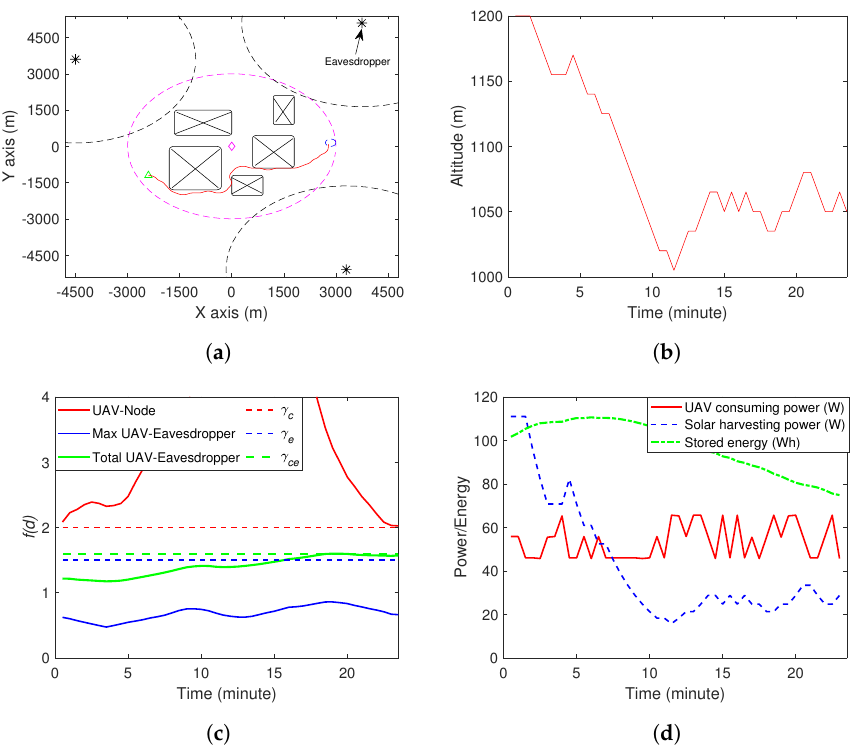
Figure 2. Simulation results in Environment 2 by the proposed method. ( a ) The UAV movement on x-y plane. A video is available: https://youtu.be/BiNL8gA0n-w. ( b ) The UAV altitude. ( c ) The communication and eavesdropping performance. ( d ) Energy consumption and solar energy harvesting.